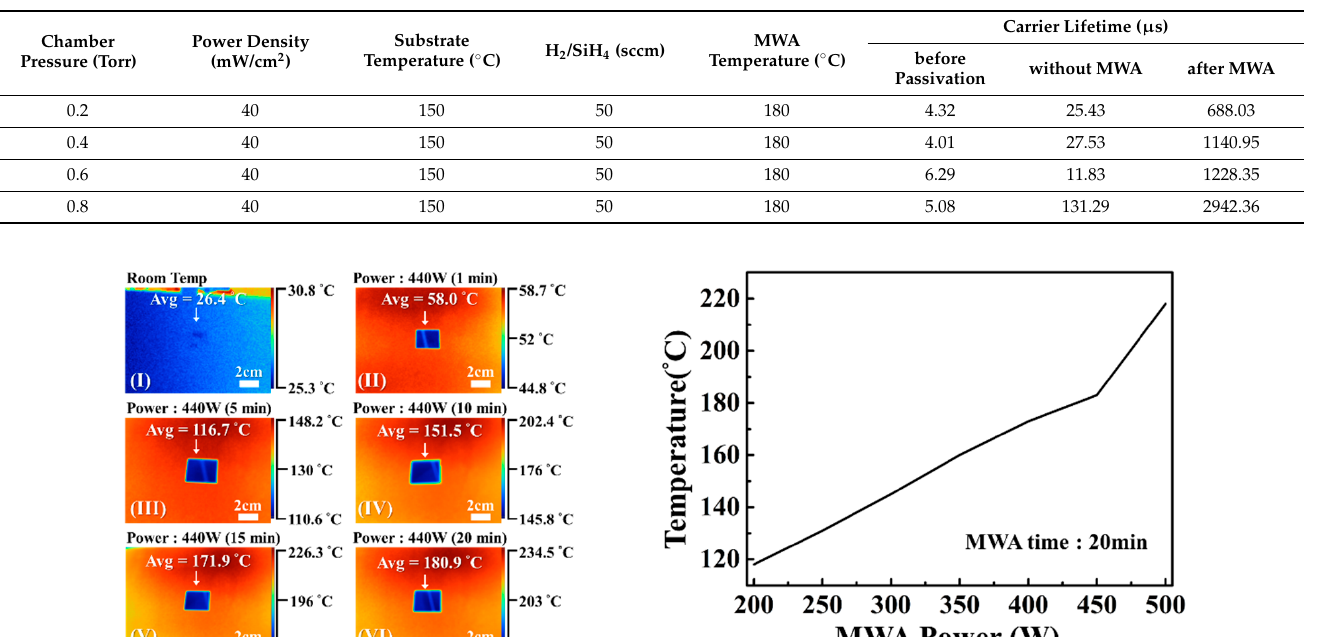
Chamber Pressure (Torr)